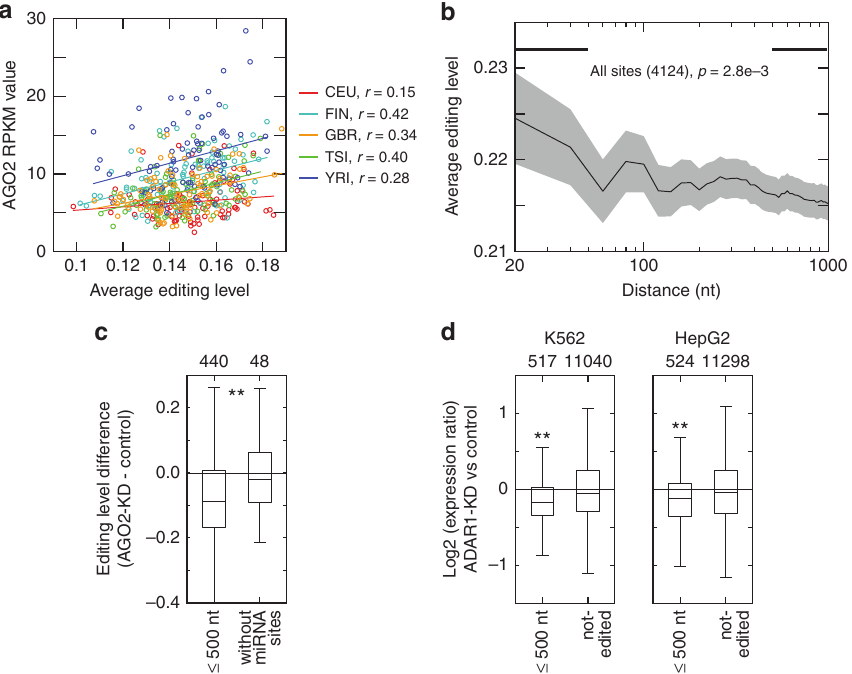
Fig. 4 Correlation between AGO2-miRNAs targeting and RNA editing levels. a Correlation of average editing levels (per individual) with AGO2 RPKM levels. Pearson correlation coef fi cients are shown. b Average editing level in dependence of the distance between an editing site and a predicted miRNA target site. The average was taken over all editing sites with distances ≤ the distance shown on the x-axis. Shaded areas represent standard error of the mean. P value is shown to compare editing level difference at editing sites close ( < 50 nt, black bar at top) and relatively far (500 – 1000 nt, black bar at top) from predicted miRNA target sites (Wilcoxon Rank-Sum test). c Editing level differences ( AGO2 KD minus control, K562 cells) of two groups of editing sites identi fi ed in the Geuvadis RNA-Seq data. Left: editing sites located in 3 ′ UTRs within 500 nt from predicted miRNA target sites; right: editing sites in 3 ′ UTRs without predicted miRNA target sites. The number of genes in each group is shown on top. P value was calculated to compare the editing level differences between the two groups of editing sites (Wilcoxon Rank-Sum test). **: p < 1e-3. d Gene expression changes upon ADAR1 KD compared